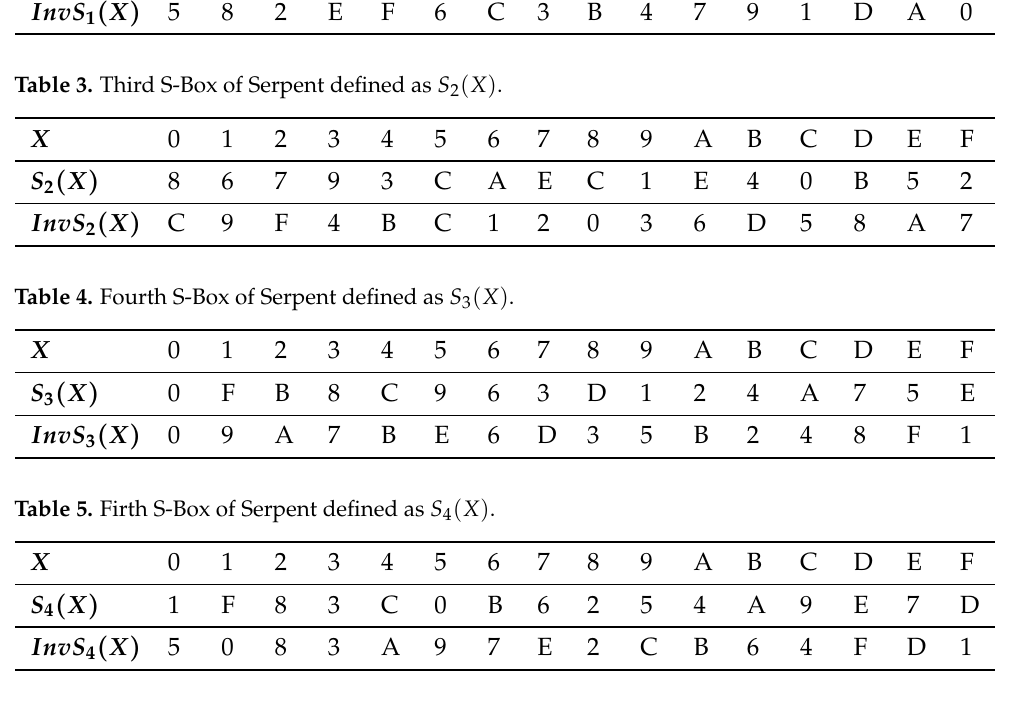
Table 6. Sixth S-Box of Serpent defined as S 5 ( X ) .